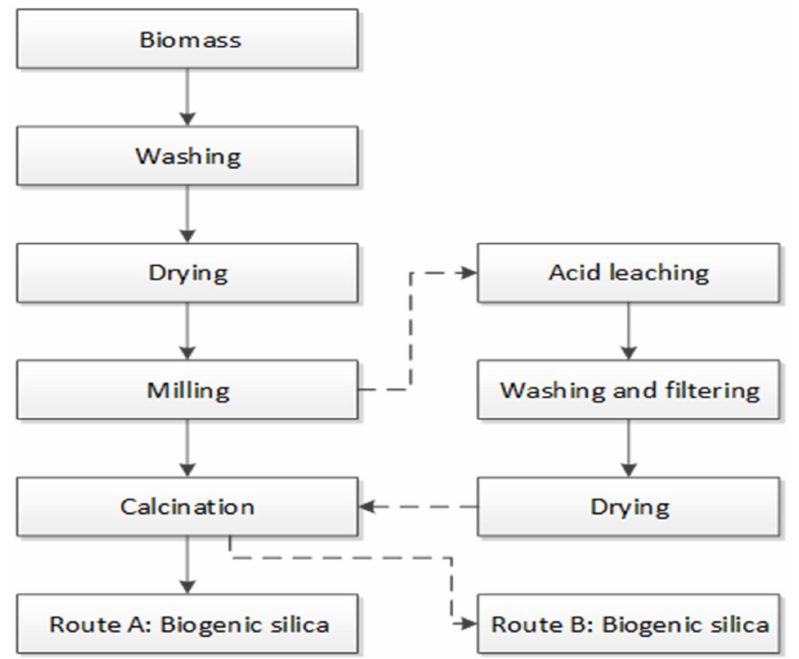
Figure 1. Extraction of biogenic silica from agricultural biomass residues to produce silica-rich